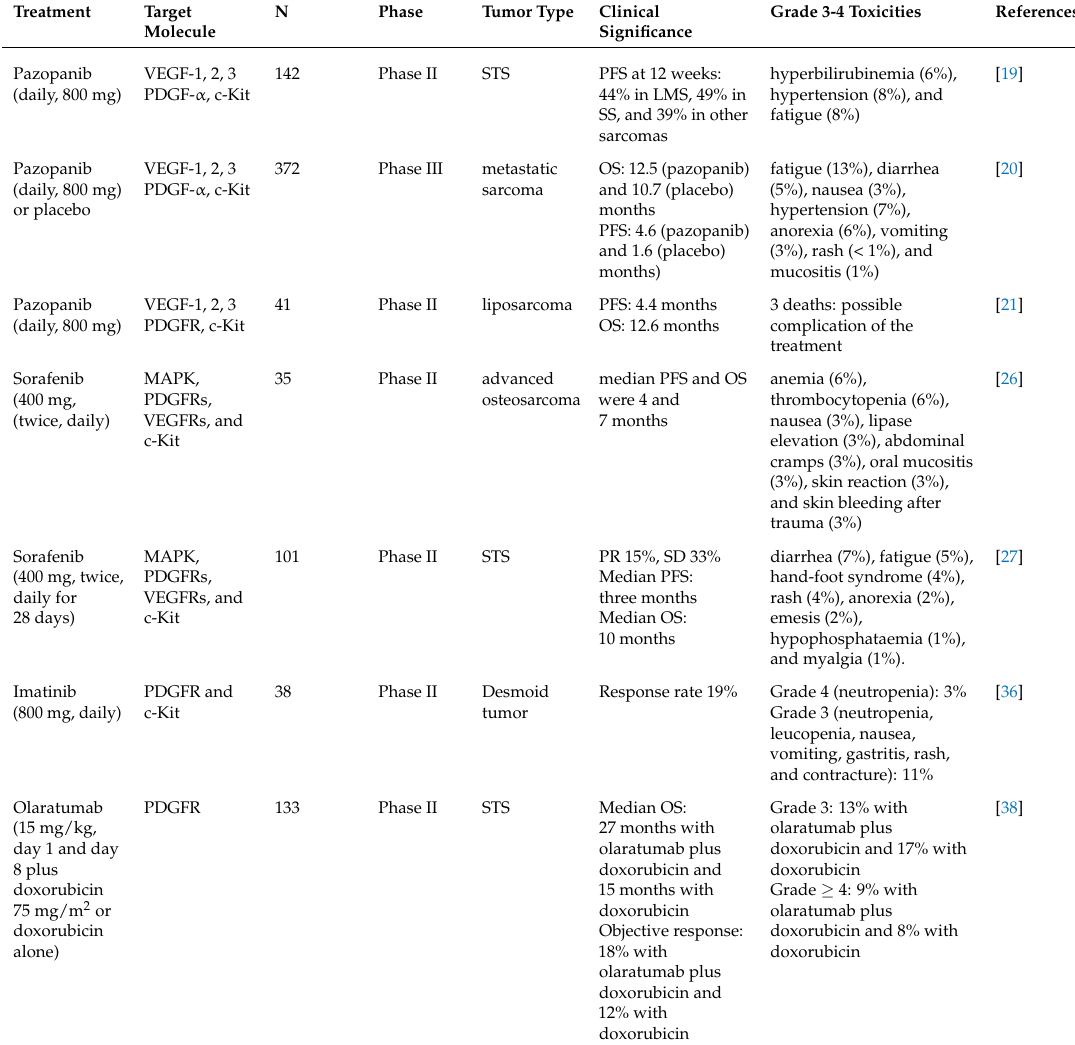
Table 1. Clinical studies and target molecules for bone and soft tissue